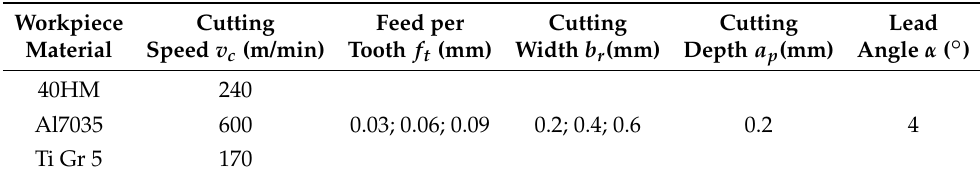
Table 1. Technological parameters used in the research.